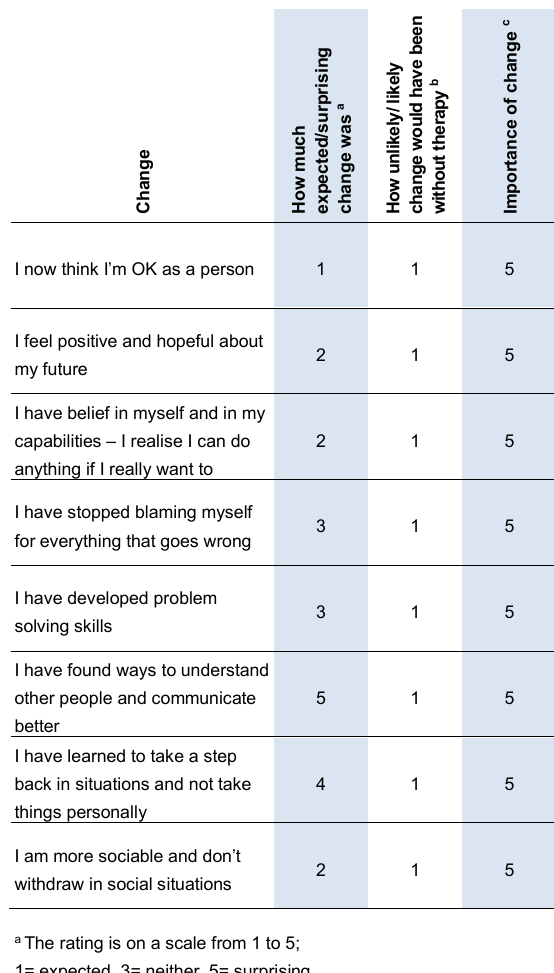
Table 2: Tom’s changes as identified in post-therapy Change